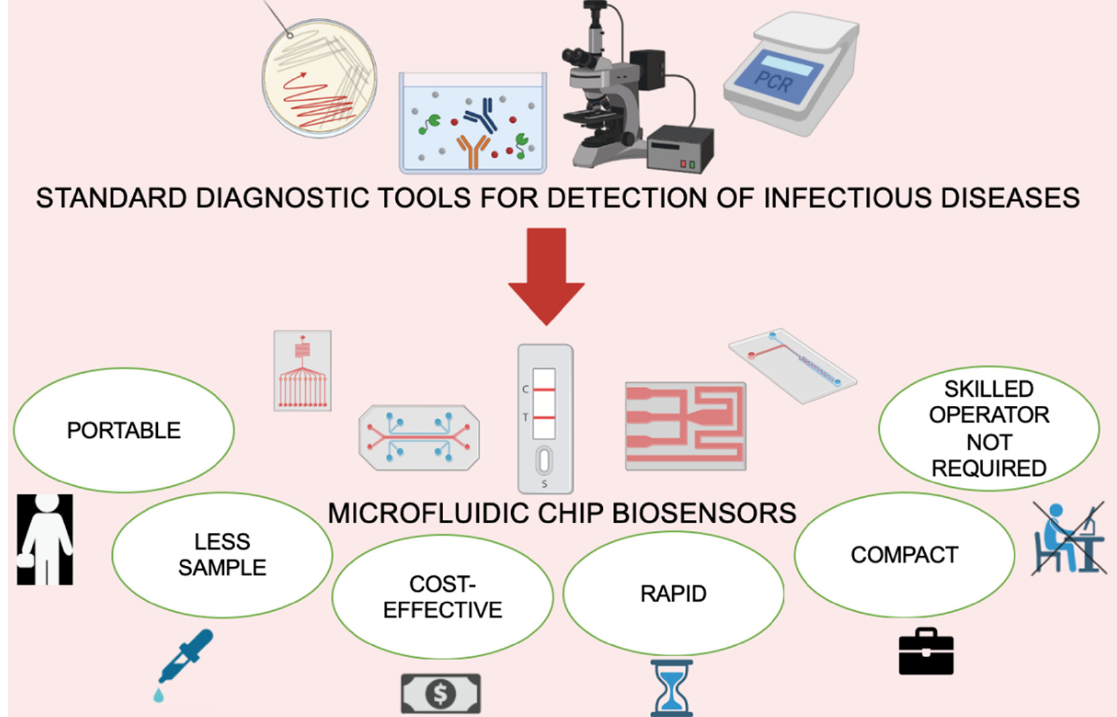
Figure 5. A schematic diagram showing the replacement of conventional techniques for the detection of infectious diseases with new microfluidic chips with advantages, such as portability, less sample requirement, cost-effectiveness, rapidity, small size (compact) and no requirement of a skilled operator. Created using BioRender.com.